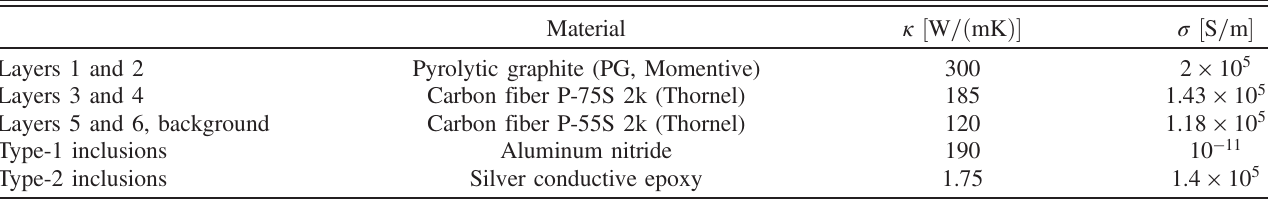
TABLE II. Realistic materials (and corresponding thermal and electrical conductivities [41]) considered for approximating the ideal-parameter synthesis in Table I and Fig.